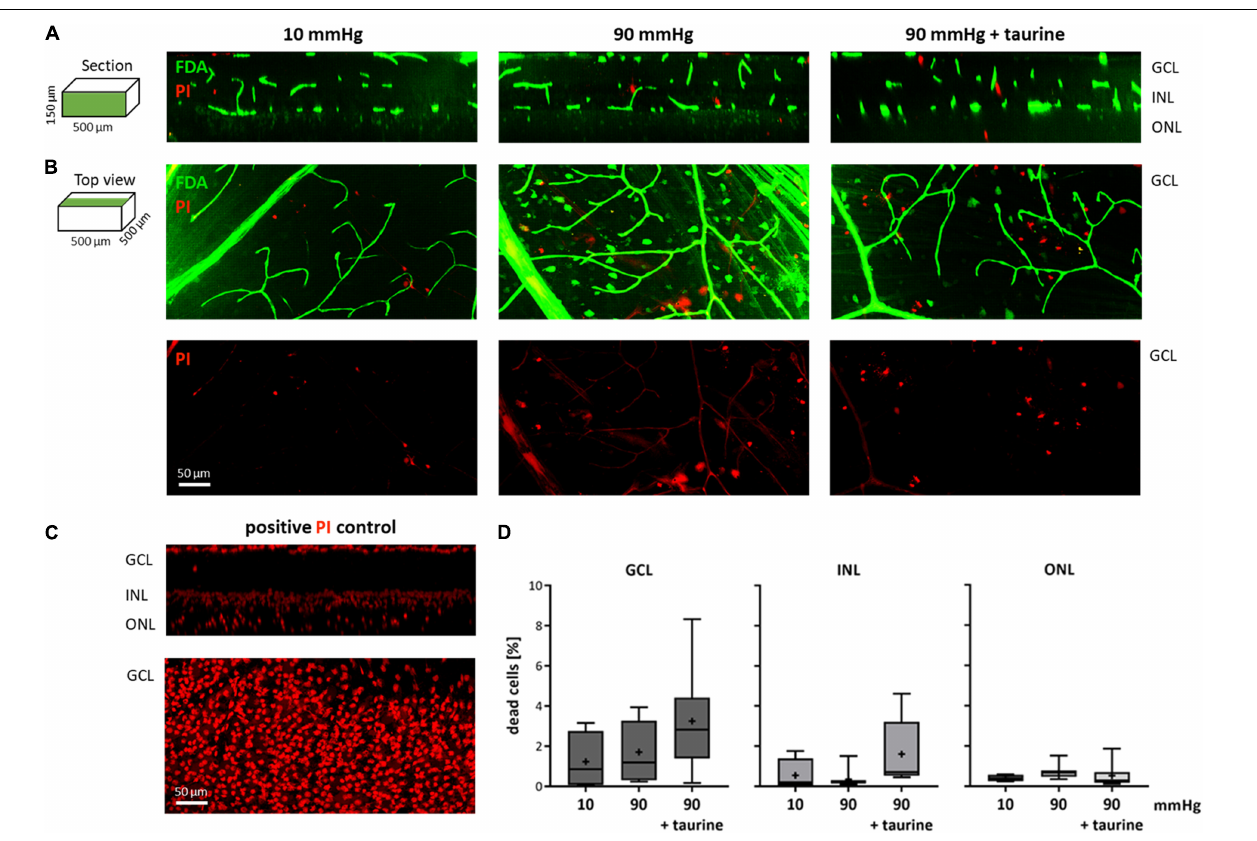
FIGURE 8 | Live/dead stained retinae after pressure stress analyzed via TPLSM. Retinae were live/dead double stained with FDA (green) and PI (red) and analyzed using a two photon microscope. Retinae that endured 10 mmHg (control), 90 mmHg, and 90 mmHg + taurine (1 mM) were analyzed. (A) Representative examples of sections through image stacks showing GCL, INL, and ONL are presented. (B) Representative examples of the top view of image stacks onto the GCL. (C) Representative section and top view of a retina after 4 h hypoxic stress (positive PI control). (D) Number of dead cells related to the number of dead cells in the positive PI control [%]. Data are presented as box and whisker (min to max) plots for GCL (dark gray), INL (gray), and ONL (light gray). Mean values are shown as + . No significant values were identified. One-way ANOVA with post hoc Tukey’s test was performed with GraphPad Prism Software version 7. (D) F (2, 17) = 1.863, p = 0.1855; F (2, 17) = 2.593, p = 0.1040; F (2, 17) = 0.6987, p = 0.5110. n retinae = 4/group, n stacks =